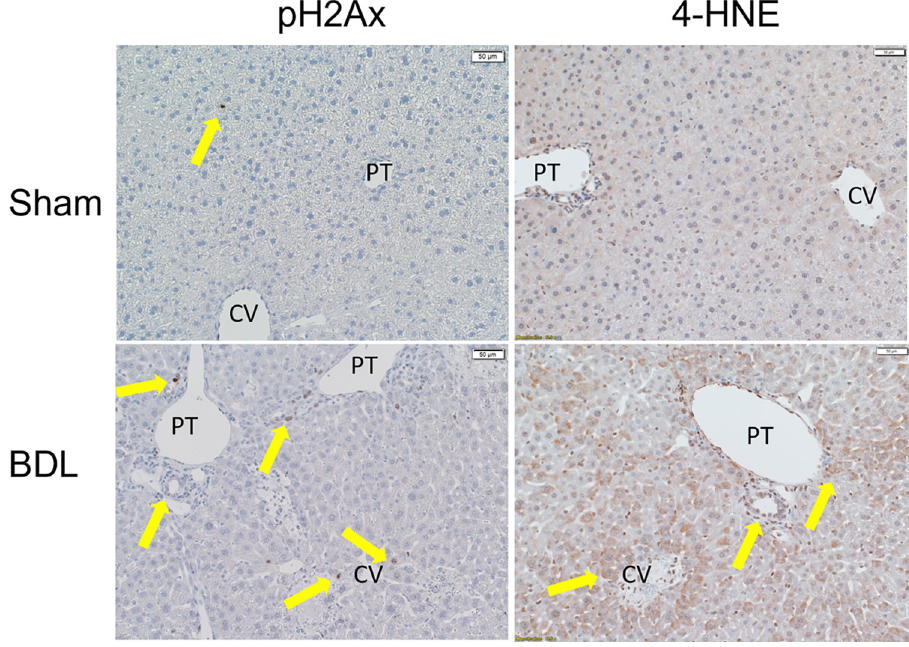
Fig 5. Increased periportal oxidative injury in acute cholestasis. Tissue sections from sham and BDL mice were probed immunohistochemically for pH2Ax and 4-HNE. N = 4/group, 200X, PT-portal triad, CV-Central vein. Arrows indicate area of increased